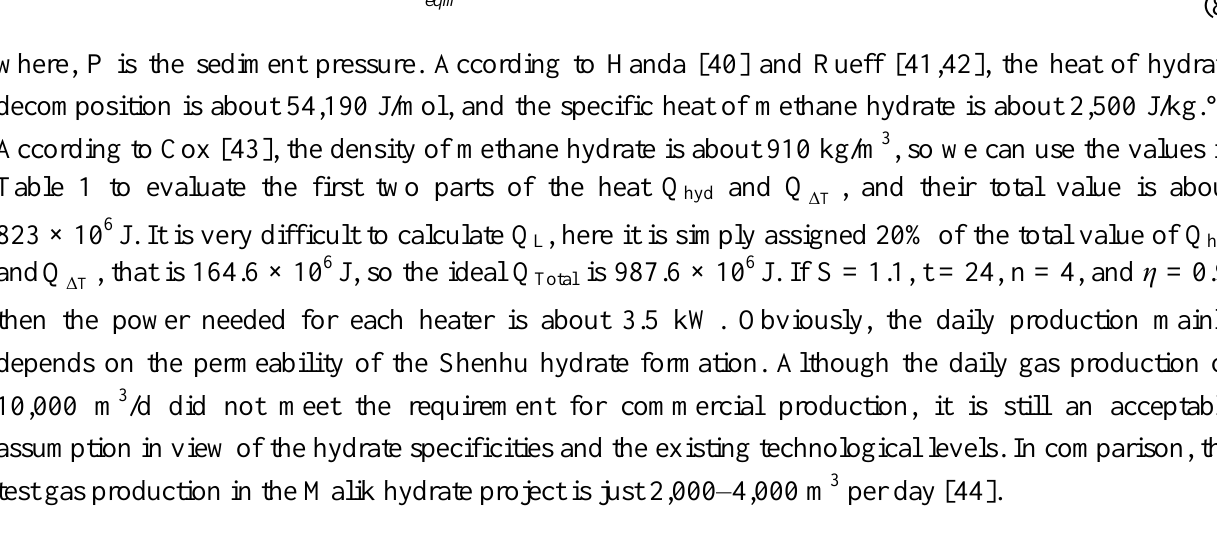
Table 1 . Parameters and values of calculating the entire energy